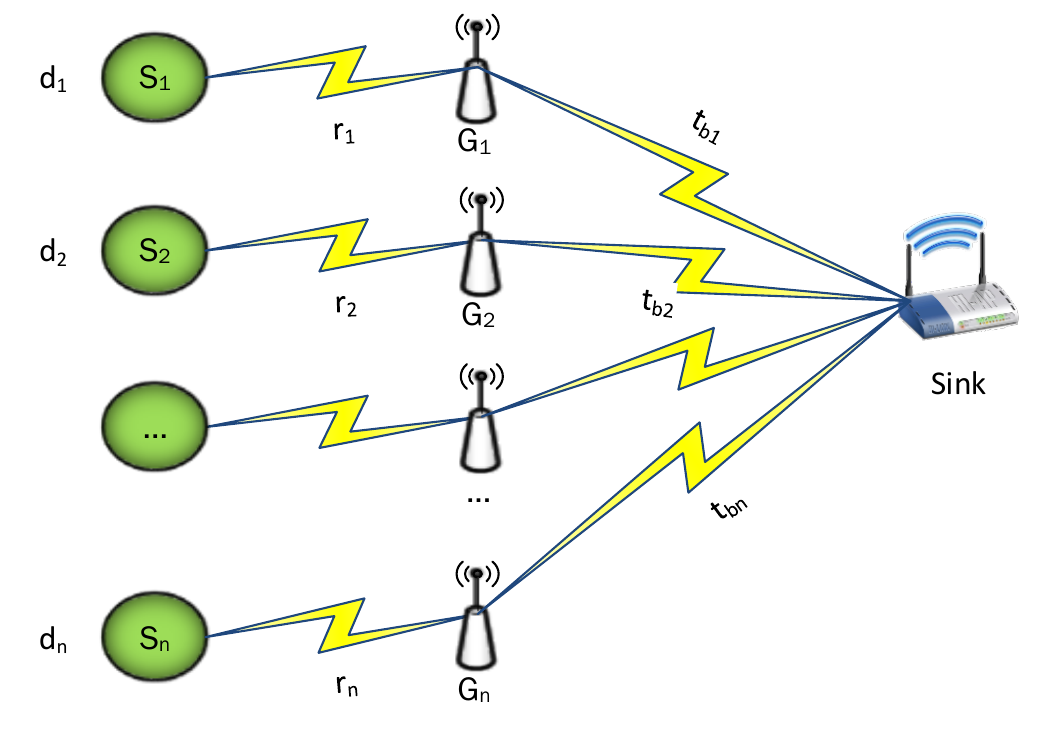
Figure 7. Typical scenario of IoT network where multiple source nodes are connected to the central sink node through intermediate gateway